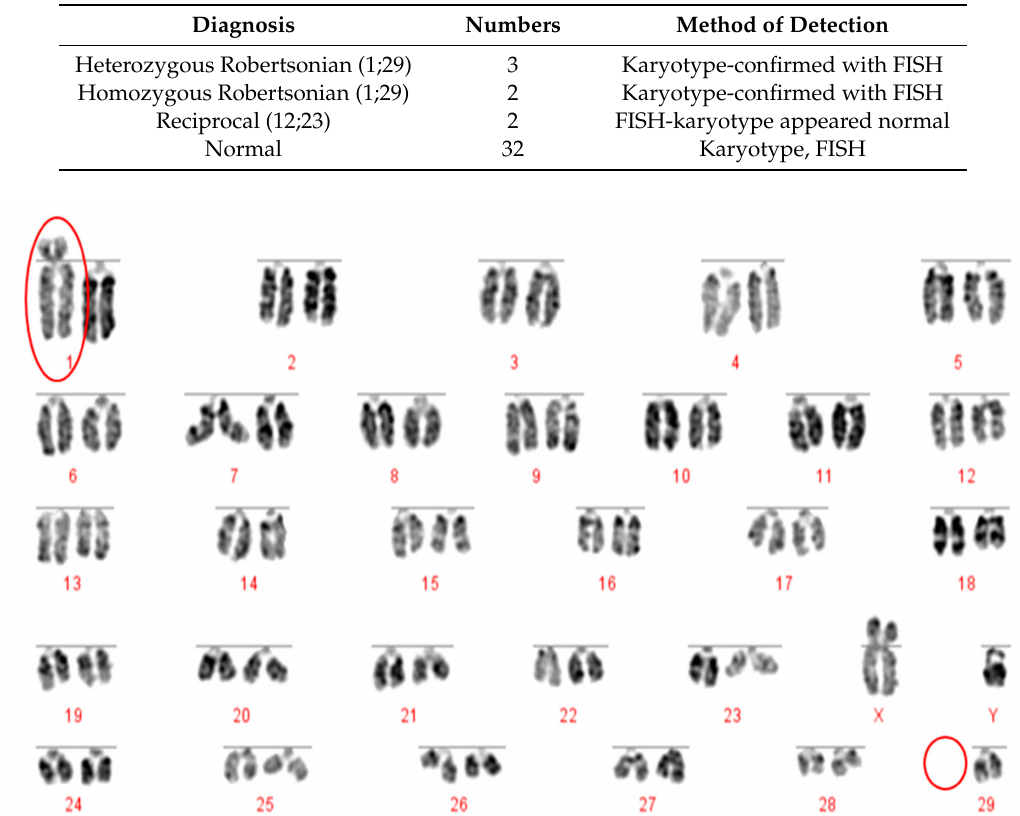
Table 2. Summary of results from screening 39 animals using karyotyping and FISH.